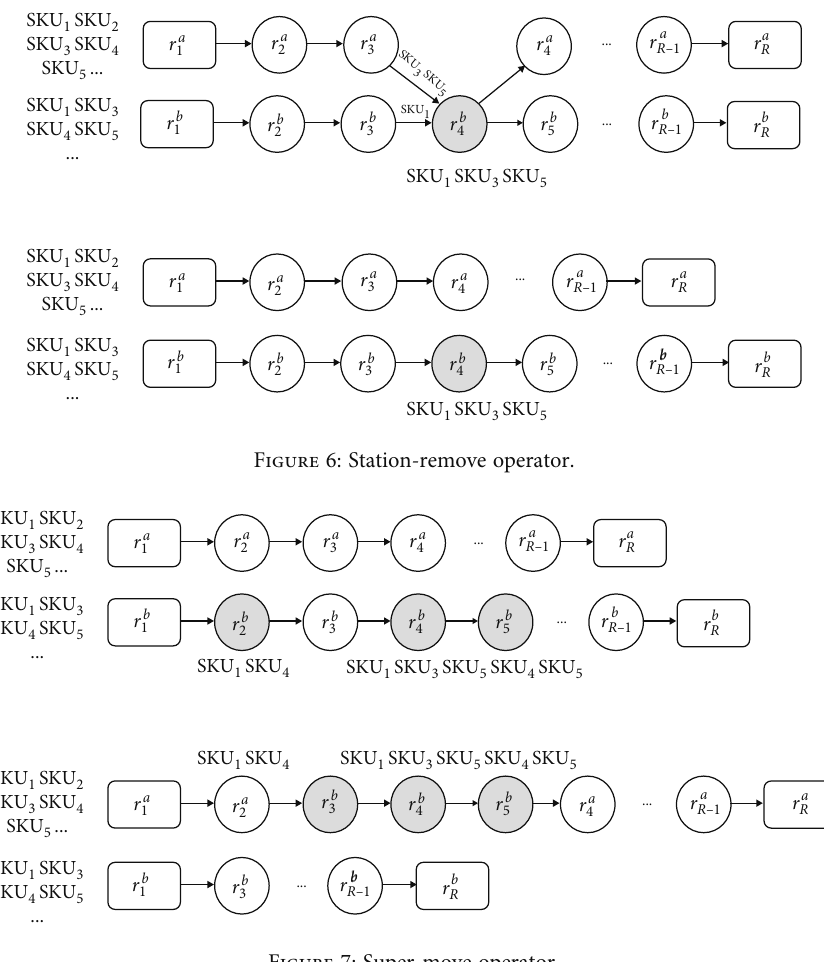
Figure 7: Super-move